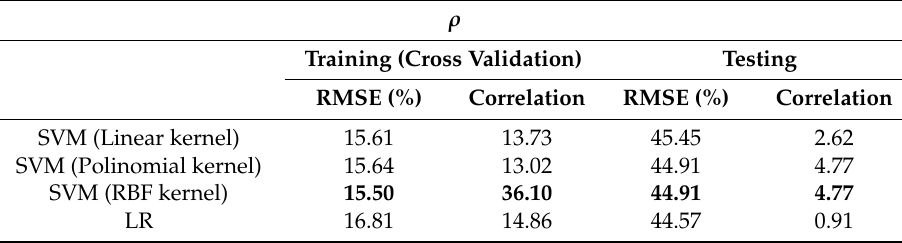
Table 10. Results obtained during the training and testing stages for ρ .